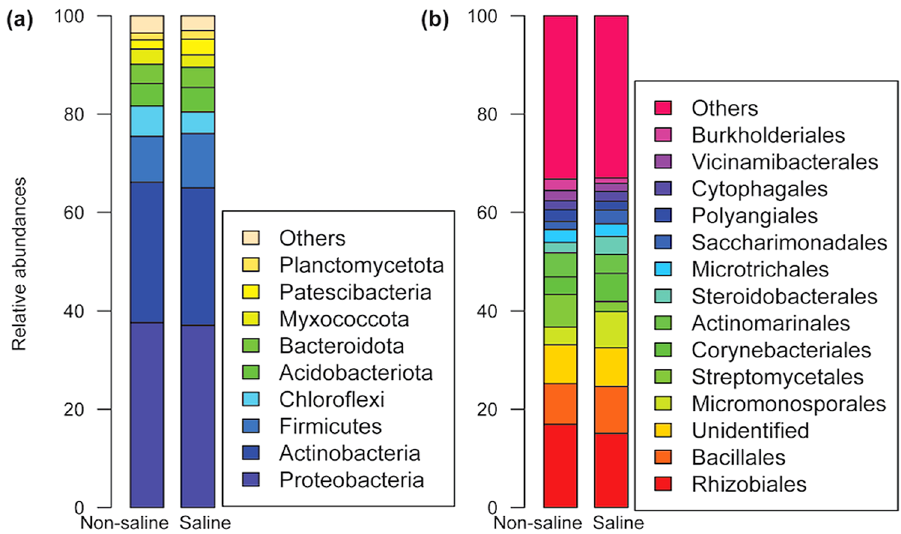
Figure 5. The relative abundance distribution of top taxa. The relative abundance at ( a ) phylum and ( b ) order levels of date palm root treated with different irrigation source (non-saline freshwater vs saline groundwater).